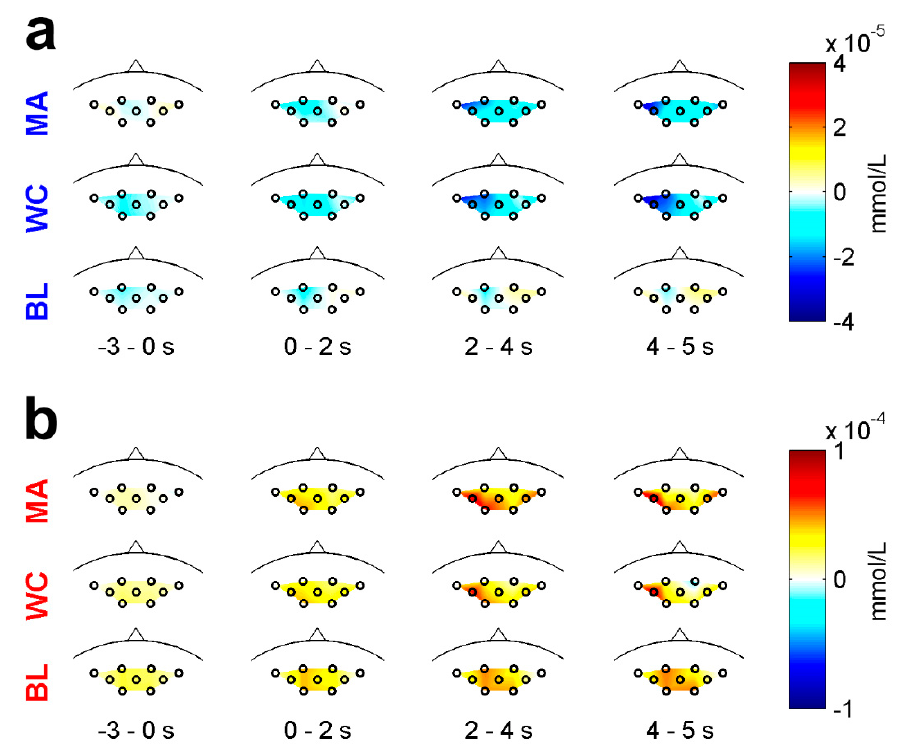
Figure 4. Scalp plot of ( a ) HbR and ( b ) HbO at given time periods for the MA, WC, and BL tasks. The colorbars indicate the amplitude in mmol/L.